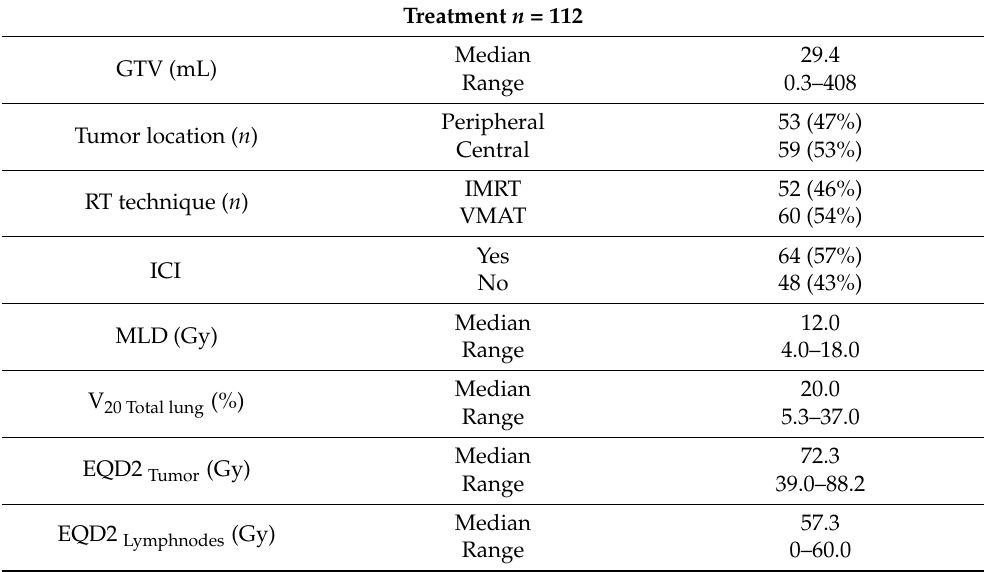
Table 2. Treatment (GTV = gross tumor volume, RT = radiotherapy, ICI = immune checkpoint inhibitor, MLD = mean lung dose, IMRT = intensity-modulated radiotherapy, VMAT = volumetric arc therapy, V20 Total Lung = lung volume receiving 20 Gy or more, EQD2 = biologically equivalent dose in 2 Gy fractions).